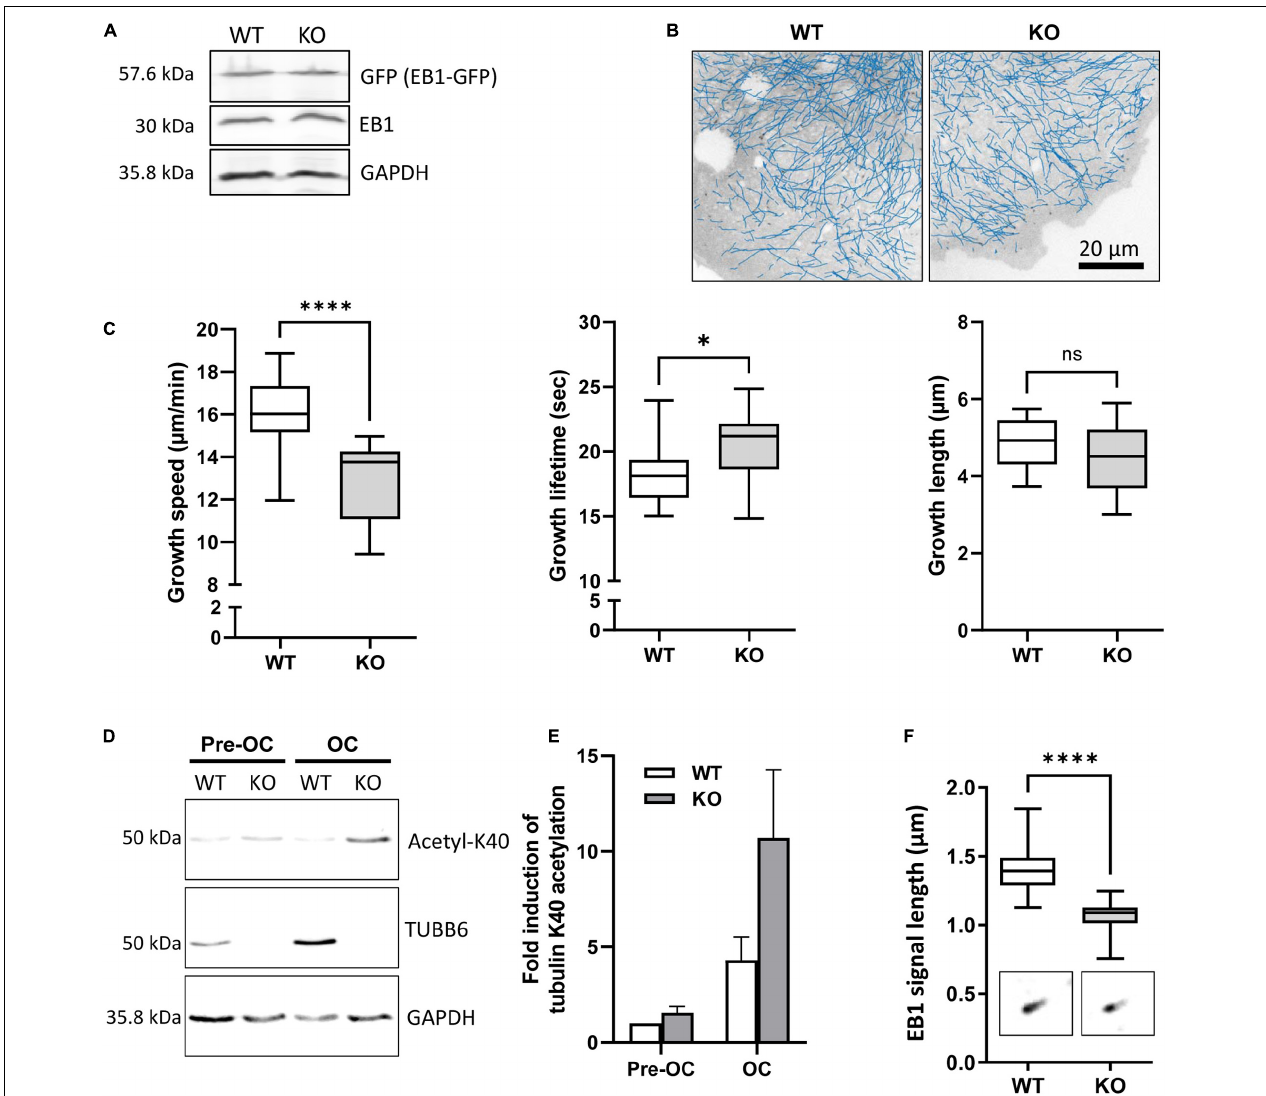
FIGURE 3 | TUBB6 regulates MT dynamics. (A) Representative immunoblot analysis of protein lysates from WT and KO osteoclasts expressing EB1-GFP (GFP); note that the expression levels of EB1-GFP and endogenous EB1 are similar in WT and KO osteoclasts. (B) Blue lines show representative EB1-GFP comet tracking using u-track software in WT and KO osteoclasts from confocal images over a period of 2 min with 1 s increment between frames (see section “Materials and Methods” for detailed settings). (C) Minimum to maximum boxplots with median and interquartile range (25–75%) showing the distribution of growth speed (left), lifetime (middle) and length (right) of EB1-GFP tracked comets per single WT and KO osteoclast, 18 WT and 14 KO osteoclasts from 3 independent experiments; Mann Whitney test: ∗∗∗∗ p < 0.0001 and ∗ p < 0.05. For details see table in Supplementary Figure 3A . (D) Representative immunoblot analysis of protein lysates from WT or KO RAW264.7 cells (Pre-OC) and derived osteoclasts (OC), showing TUBB6, acetylated K40 α -tubulin (acetyl-K40), and GAPDH expression. (E) Bar graph shows mean and SEM levels of acetylated K40 α -tubulin in WT and KO pre-OC and OC, normalized to 1 in WT pre-osteoclasts, from four independent experiments. (F) Minimum to maximum boxplot showing endogenous EB1 cap length in WT and KO osteoclasts, measuring 25 comets in each osteoclast to determine the average cap length per osteoclast, in 27 WT and 27 KO osteoclasts from three different experiments; Mann–Whitney test: ∗∗∗∗ p <